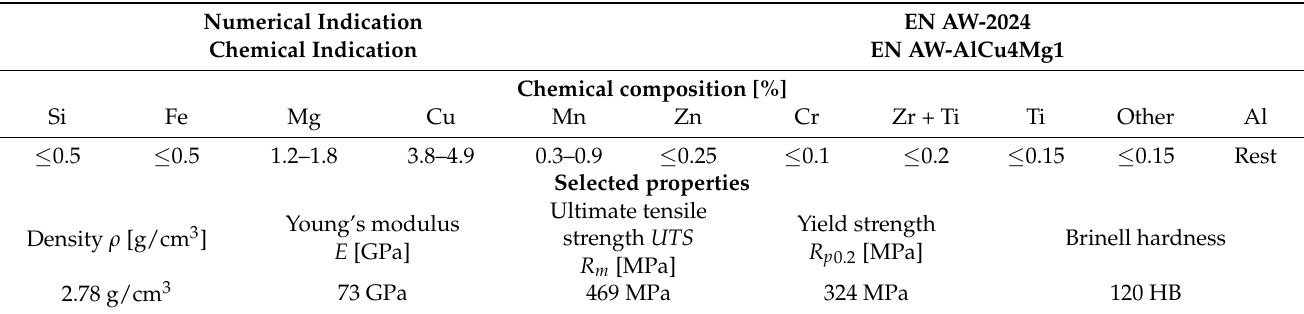
Table 1. Chemical composition and selected properties of EN AW-2024 T351 aluminum alloy